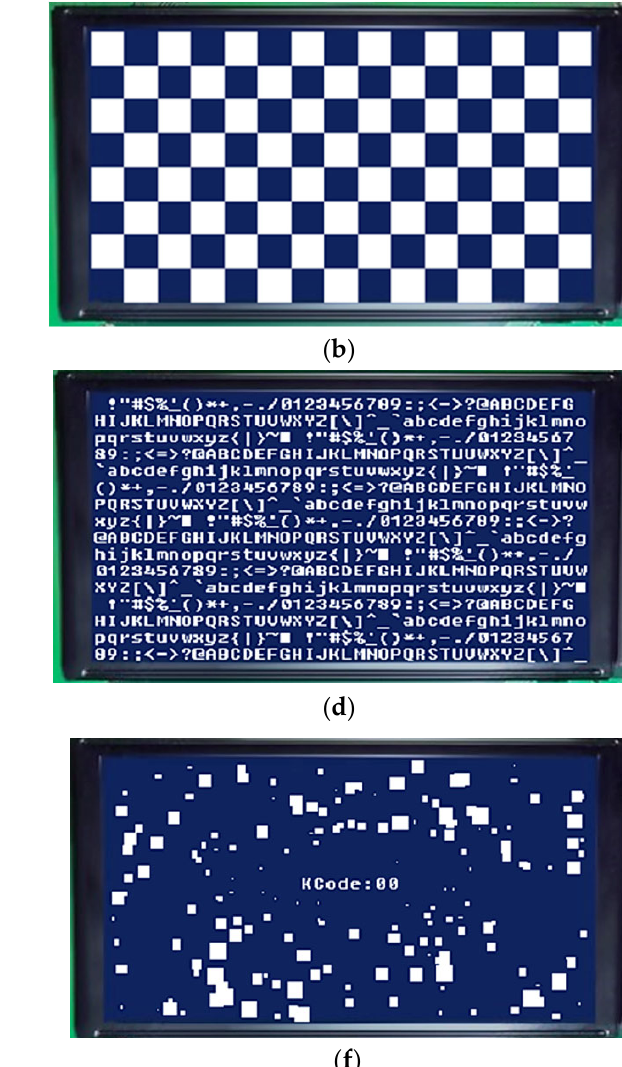
( b ) Figure 14. Virtual simulator of the RPILAB didactical module running demo program: ( a ) simulator com ‐ ponents and GUI; ( b ) simulator running on Microsoft Windows platform under Eclipse IDE control. 4.4. Simulators Tests Results The two developed virtual simulators are running under the Microsoft Windows OS with embedded software compiled for Intel x86 architecture. For this reason, a compari ‐ son of performance, memory footprints, or timing relations of both platforms would be